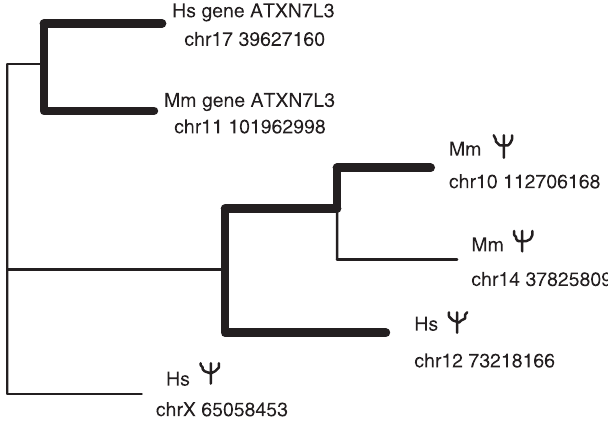
Figure 4. Visualization of the Effect of Mutual-Best-Hit Filtering The tree shows the evolutionary history for a sequence set associated with the ATXN7L3 orthologous proteins. We have here found two